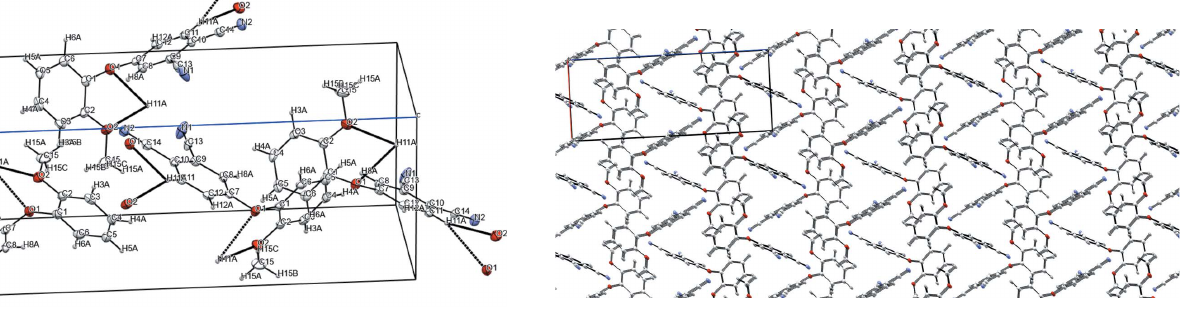
Figure 5 Representation of bifurcated O (cid:4)(cid:4)(cid:4) H (cid:4)(cid:4)(cid:4) O hydrogen bond exhibited by the m -4-(2-methoxyphenoxy)phthalonitrile dimer. Displacement ellipsoids are drawn at the 50% probability level.